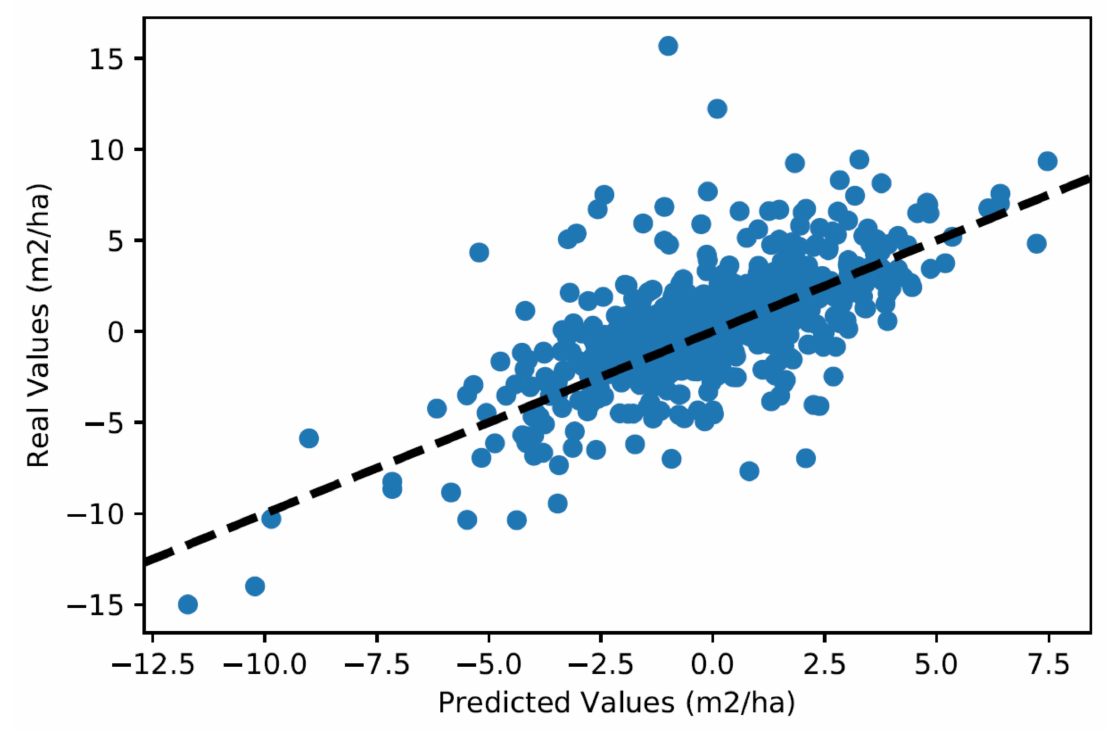
Figure 13. Residuals plot for ∆ G predictions at the level of couples (division, inventory